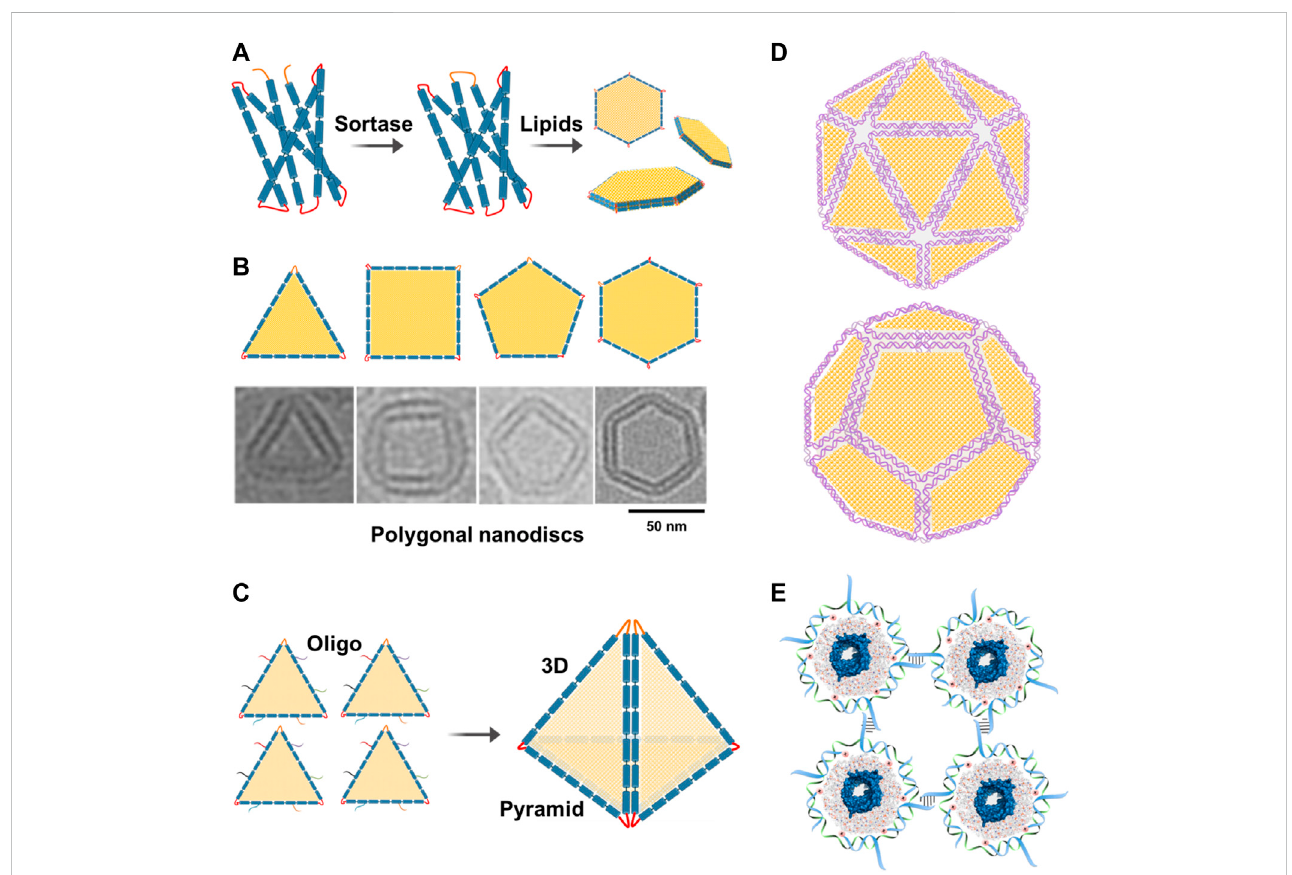
FIGURE 5 Future directions. (A) Assembly of polygonal nanodiscs. Large circularizable membrane scaffold proteins can be engineered to allow the assembly of well-de fi ned polygonal shapes such as hexagonal nanodiscs. (B) Cryo-EM images of individual nanodiscs with different shapes. Adding more lipids to these nanodiscscanchangetheirshapesbacktocircularnanodiscs. (C) Polygonalnanodiscscanbeusedtoassemble3Dstructuresthatcanbeusedindrugorgene delivery. For example, four triangular nanodiscs can be stitched together with the help of complementary oligos to assemble a pyramid which can be usedinthedeliveryofdrugsorgenes. (D) PolygonalDNAnanodiscscanbeusedtoassemble3Dstructuresofwell-de fi nedsizesandshapessimilartoviruses. Additionally, these particles can be further modi fi ed with ligands or proteins on their surfaces. (E) DNA-corralled or DNA-belted nanodiscs containing membrane proteins can be used to form 2D lattice or functional